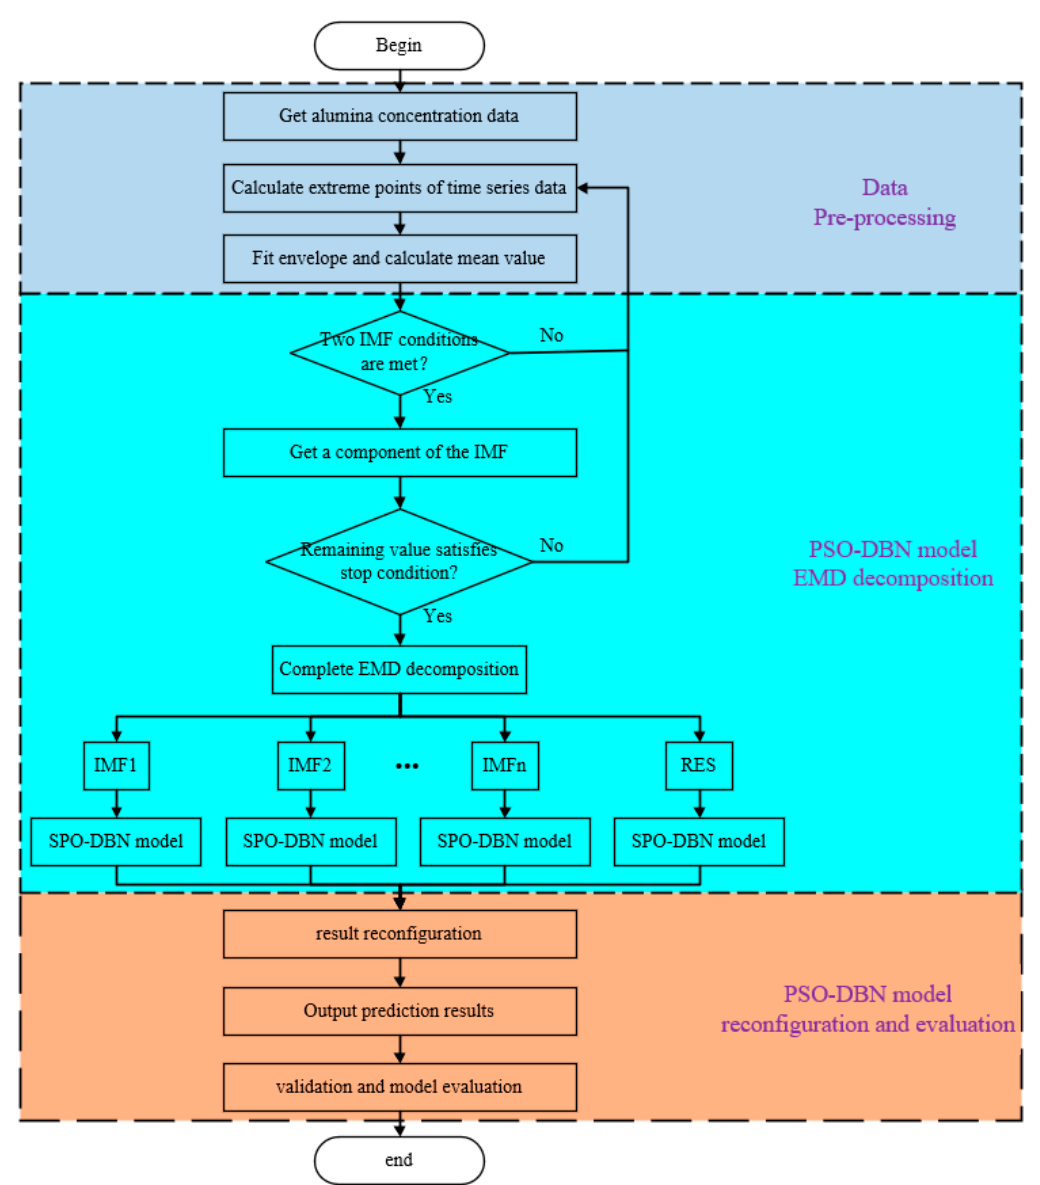
Figure 6. Flow chart of soft-sensing model based on EMD–PSO–DBN.